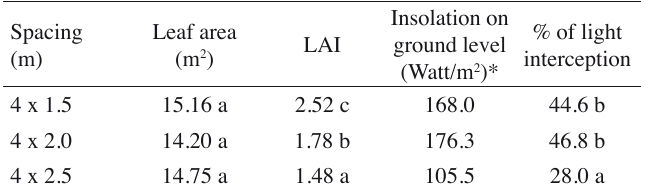
Table 6 - Influence of spacing on leaf area, leaf area index (LAI), and light interception of ‘Silvia’ cultivar in the fifth year from planting (2009)